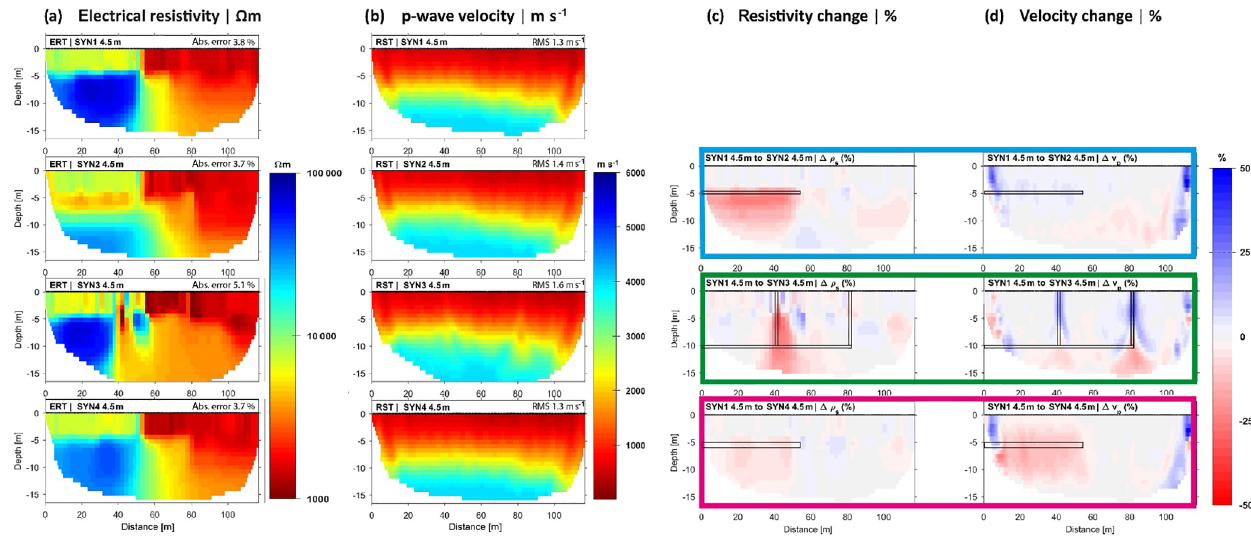
Figure 5. Inverted synthetic model sections of the synthetic model scenarios of Fig. 4 for (a) ERT and (b) RST, and percentage changes between (c) ρ s and (d) v p of the three scenarios with respect to the baseline model. The positions of the introduced changes between the different scenarios are indicated by black